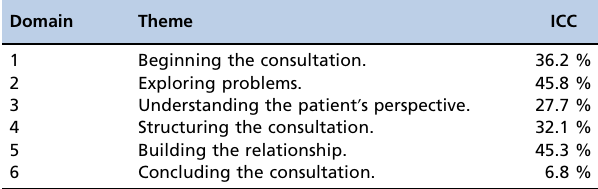
Table 2 - Intraclass correlation coefficients (ICC) for each domain (in